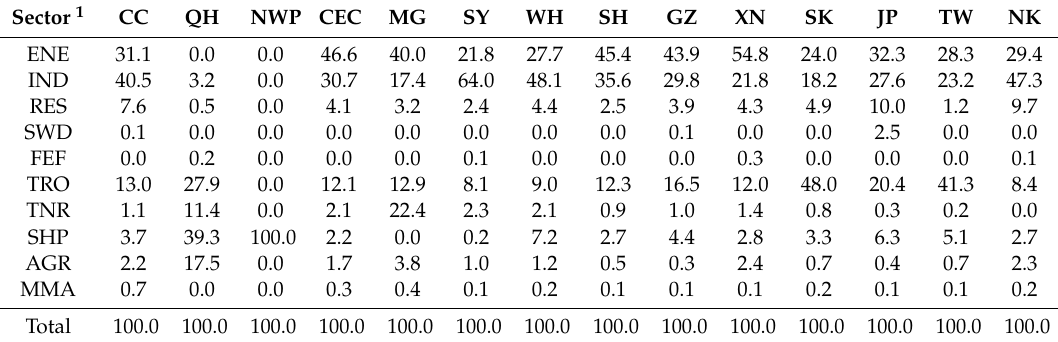
Table 2. NO x emission contribution by sector from the CAMS inventory for 2006–2015